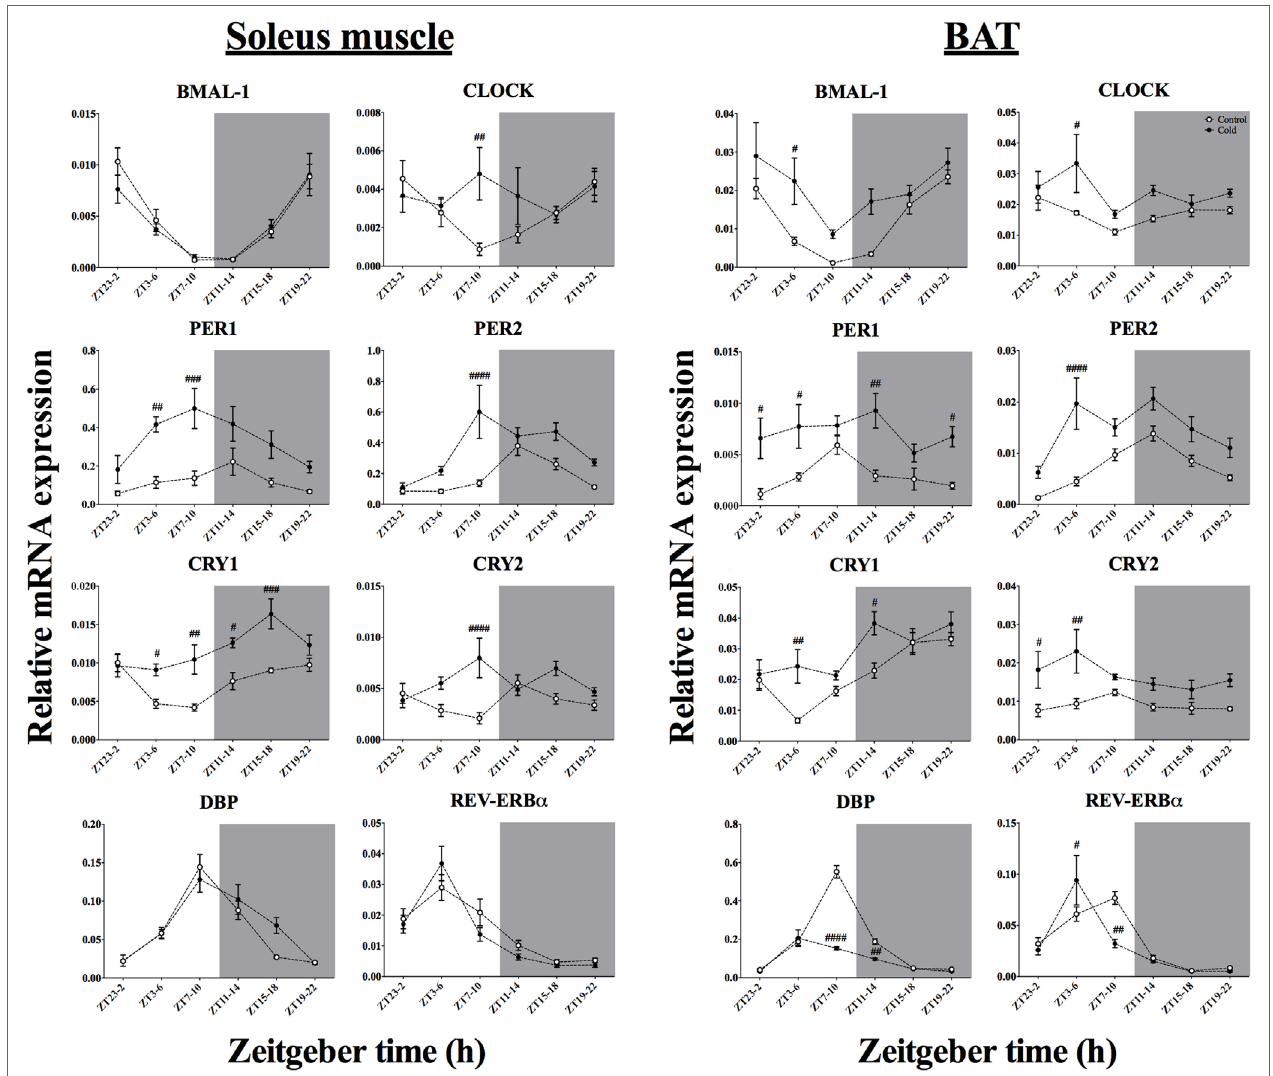
FigUre 6 | Effect of time­of­day on clock gene expression in both soleus muscle and brown adipose tissue (BAT) after exposure to environmental cooling. Light phase began at Zeitgeber Time 0 (ZT0) and dark phase (shaded areas) began at ZT12. Results are presented as mean ± SEM. p < 0.05. # indicates differences between control and cold conditions, p < 0.05 . n =